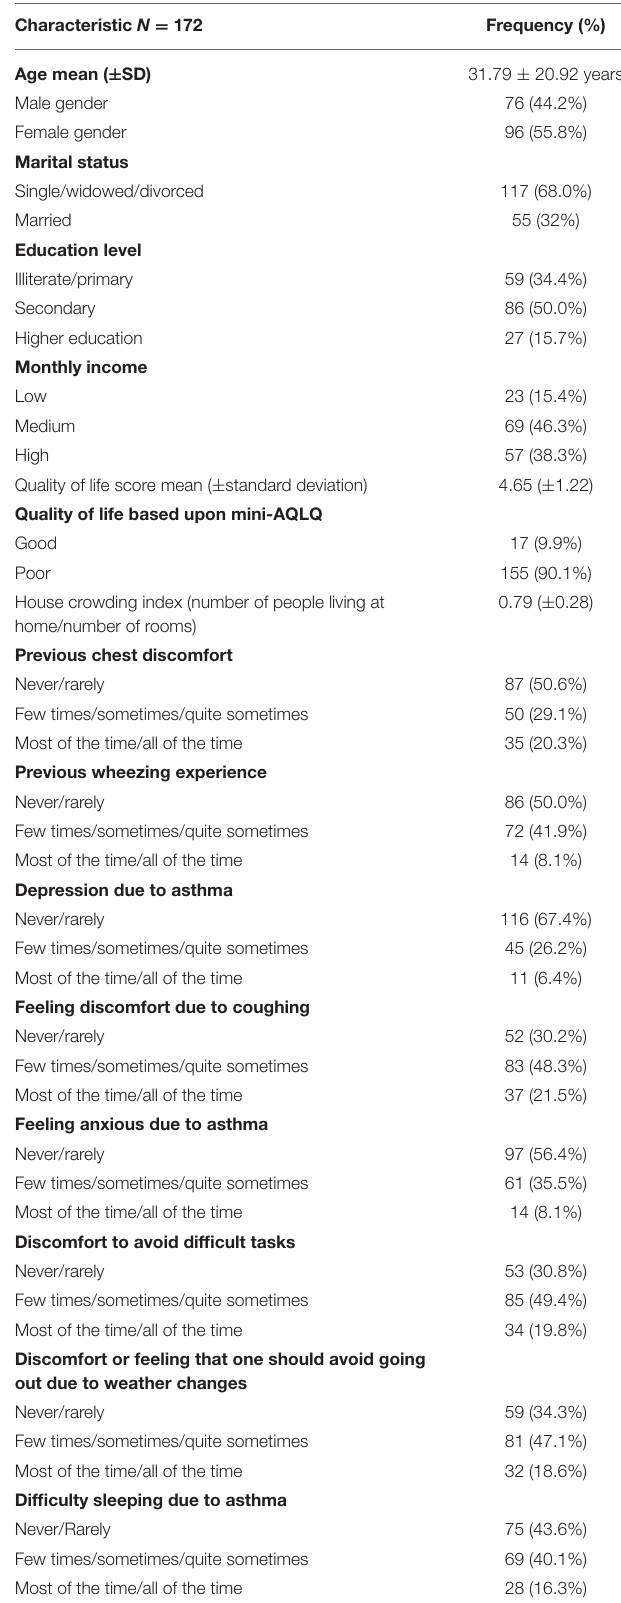
TABLE 1 | Demographic characteristics of study